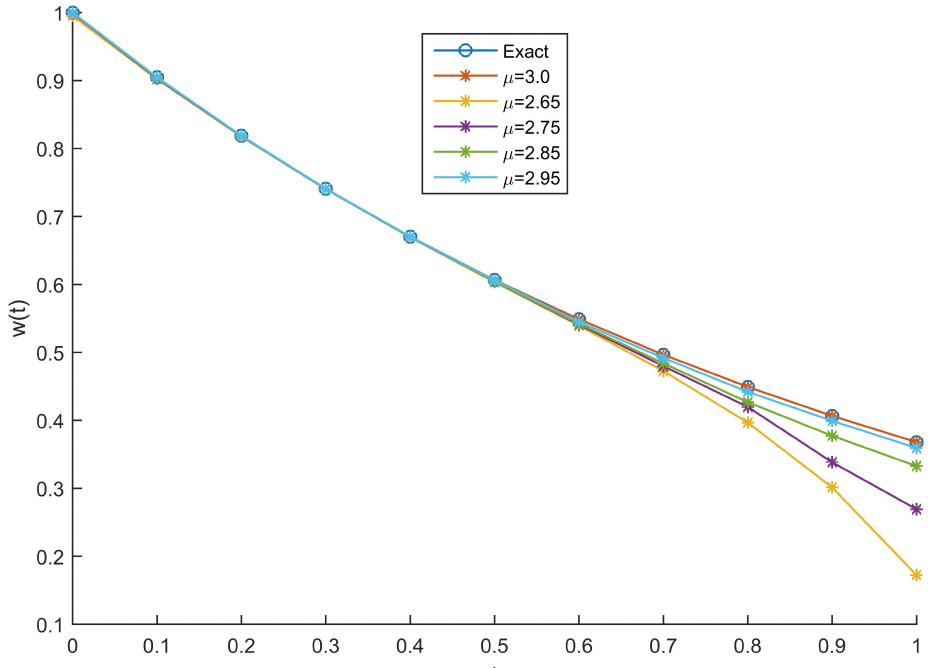
Figure 1. The comparison between the exact solution and the approximate solutions obtained for the various values of µ